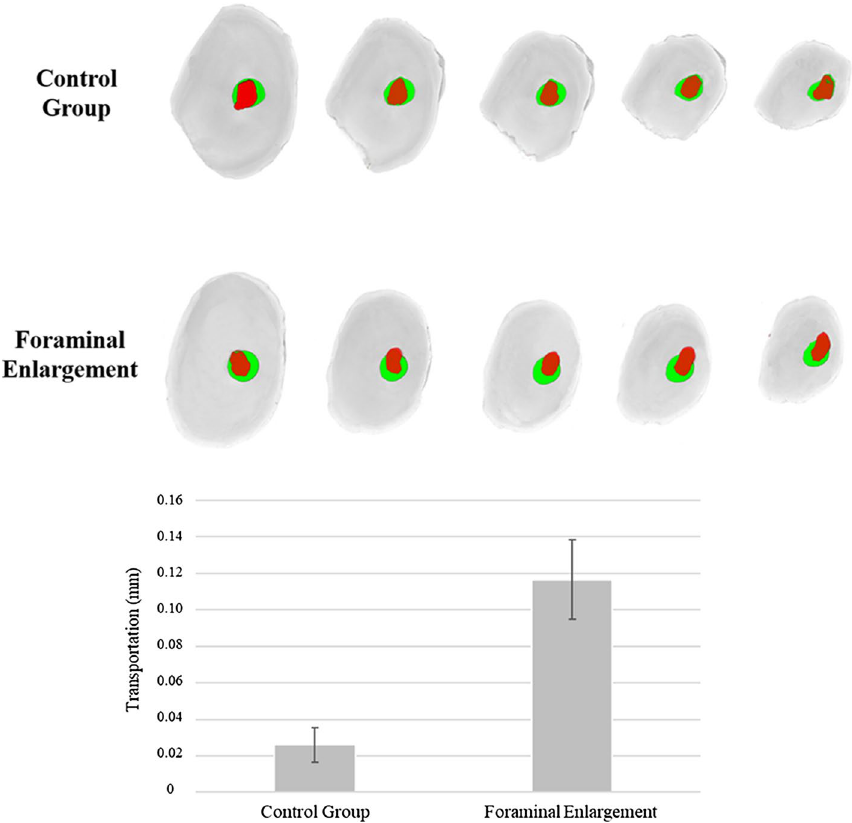
Figure 2. Representative cross-sectional of 3D reconstructions showing superposition of the root canal before instrumentation (red) with after instrumentation (green) and bar chart showing mean and standard deviation of the transportation (mm) caused in the root canals after